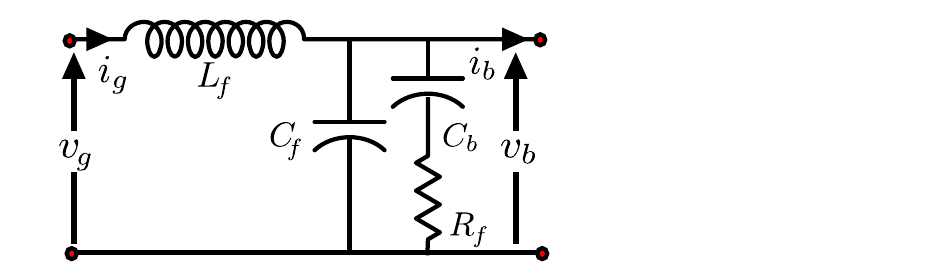
Figure 2. Damped input filter circuit with L f , C f as main LC filter and the series combination of R f , C b as parallel damping branch.